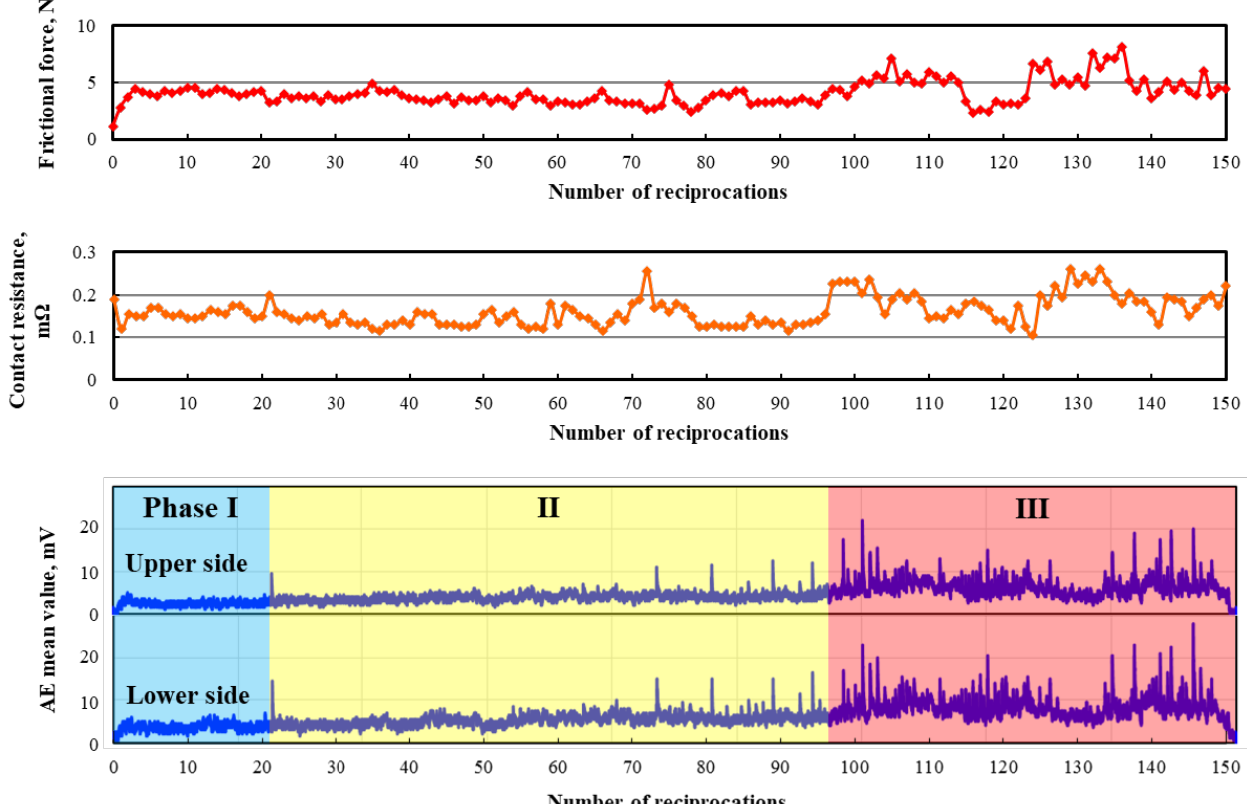
Figure 14. Changes in the frictional force, contact electrical resistance and AE signals for the three phases of wear ( t = 0.64 mm, Ag plating 5 µm, v = 200 mm/min, HPF: 50 kHz).